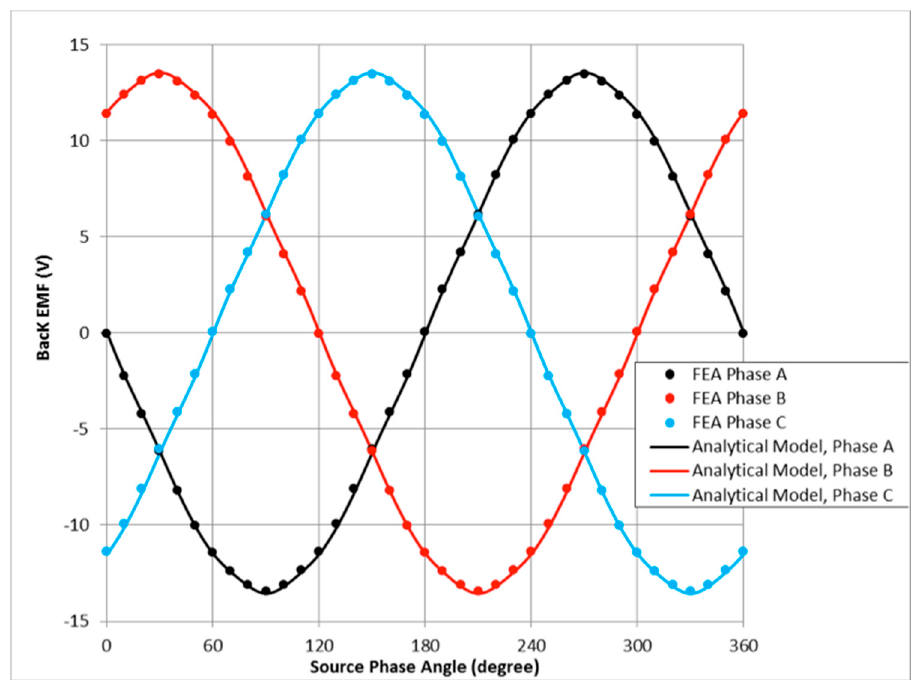
Figure 9. Analytical and MotorSolve Predictions of Cogging Torque in the 12 s/10 p Halbach Machine with R mp = 0.5.